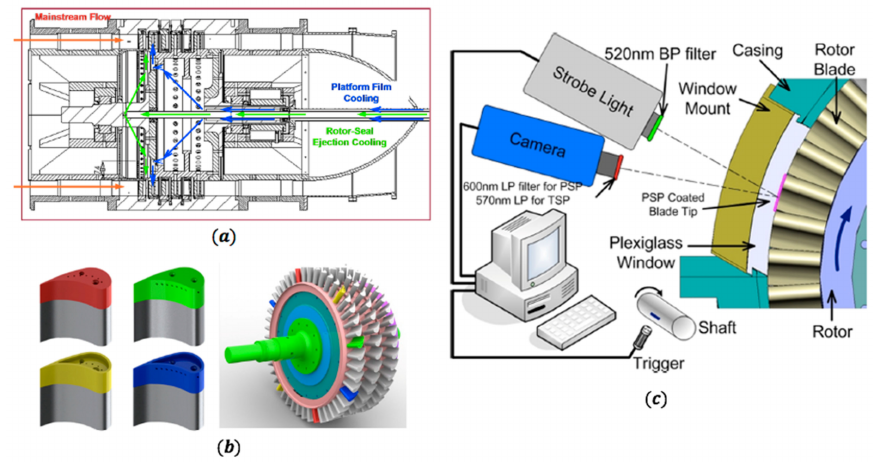
Figure 13. ( a ) Rotating rig at Turbomachinery Performance and Flow Research Laboratory at TAMU, ( b ) different blade tip cooling designs, ( c ) film cooling measurement setup based on PSP [48]. Reprint with permission from ASME (order number 1084748).